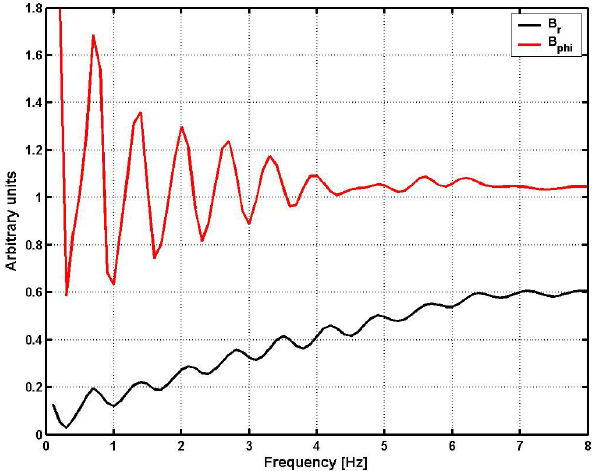
Fig. 2. The same as Fig. 1 but for the station CR and 02:00UT on 3 January 2000 based on a modified IRI model and the following parameters: θ =39 ◦ , φ =70 ◦ . For more details see